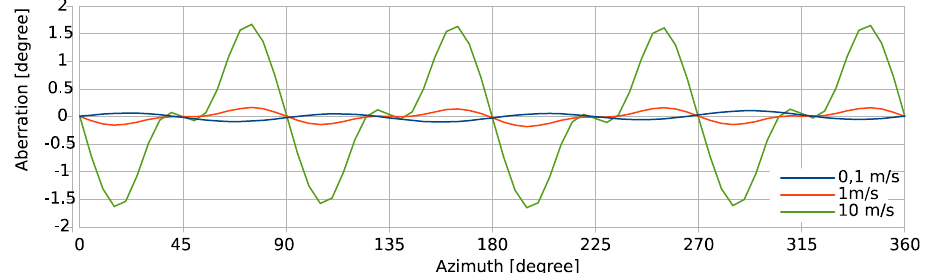
Figure 12. Simulated differences between the set angle of the flow and the angles computed from Equation (6) and the voltage vectors of the “wide” thermistor bridge arrangement.